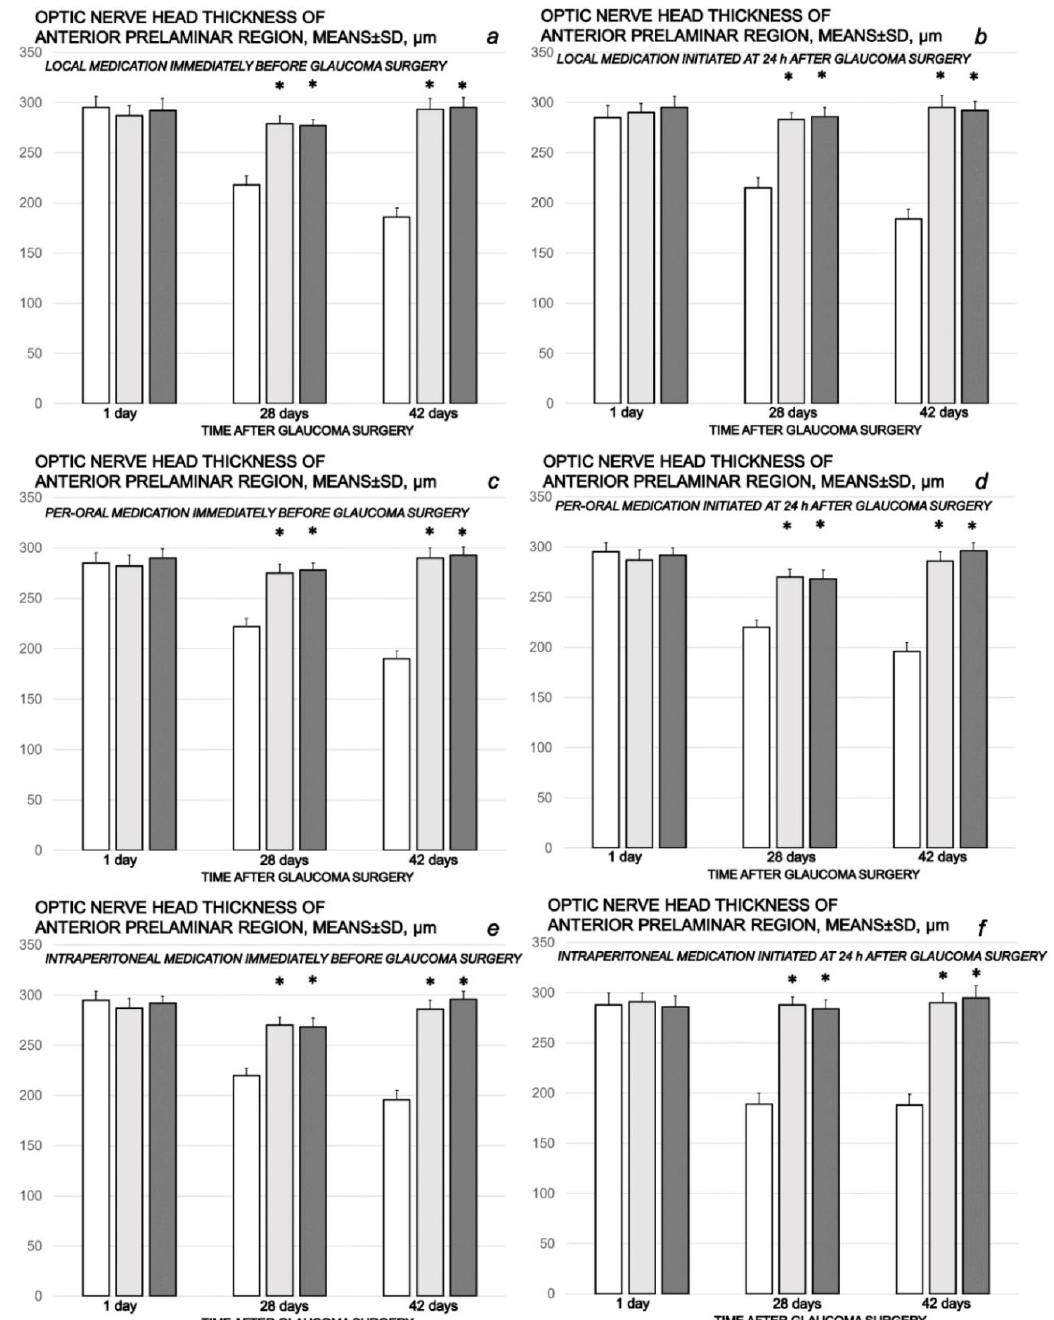
Figure 13. Cauterization of the three episcleral veins induced a decrease in optic nerve head thickness of anterior prelaminar region, means ± SD, µ m, at the first post-operative day and at the end of the fourth and sixth post-injury week. Counteracting effect of BPC 157 medication daily regimen, prophylactic ( a – c ) or curative ( d – f ) (gray bars, light gray bars µ g-regimen, dark gray bars ng-regimen (0.4 µ g/eye, 0.4 ng/eye; 10 µ g/kg, 10 ng/kg) given locally as eye drops in each eye ( a , d ), intraperi- toneally (last application at 24 h before sacrifice) ( b , e ) or per-orally in drinking water (0.16 µ g/mL, 0.16 ng/mL, 12 mL/rat until the sacrifice, first application given intragastrically) ( c , f )), started pro- phylactically (immediately before glaucoma surgery) or as curative treatment (at 24 h after glaucoma surgery). Controls (white bars) simultaneously received an equal volume of distilled water (two drops/eye), saline intraperitoneal application (5 mL/kg) or per-oral drinking water (12 mL/day/rat). * minimum p < 0.05 vs. control. A total of 6